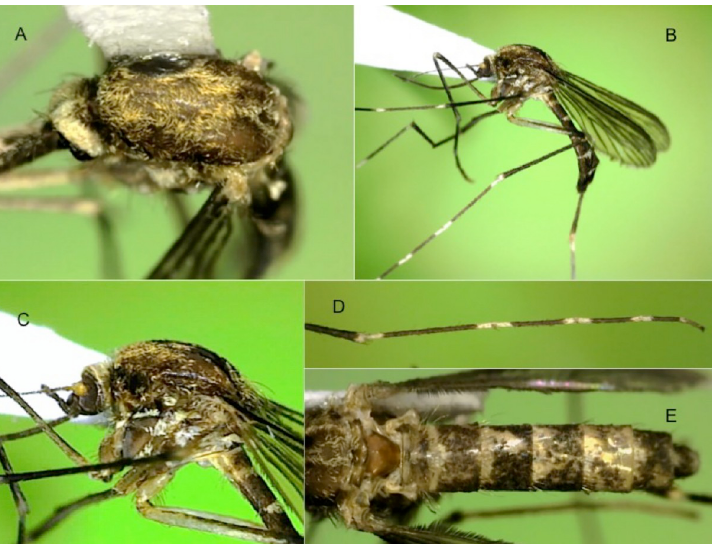
Fig 3. Adult female of Aedes ( Ochlerotatus ) amateuri . A: Dorsal view of the scutum. B: Laterial view of the body. C: Lateral view of thorax. D: Lateral view of foreleg. E: Dorsal view of abdomen. light brown scales on dorsolateral, lateral and ventral surfaces, the darkest scales usually dorso- lateral. Proboscis 1.1–1.2 length of forefemur, dark-scaled. Palpus about 0.2 length of probos- cis, with 3 obvious palpomeres, dark-scaled. Antenna subequal to proboscis in length; pedicel usually yellow, darker and with a few light or dark scales mesally; flagellomere 1 slightly swol- len, with white scales mesally. Thorax (Fig 3A): Acrostichal setae few, on anterior area of scu- tum; dorsocentral setae few, on anterior and posterior areas of scutum; prescutellar and supraalar setae numerous; humeral setae 2, 3. Scutellum with 10–12 setae on each lobe. Scutal scales narrow, curved, whitish, dingy white, or cream-colored on anteriorly, around prescutel- lar space and in antealar area, yellowish in diffuse narrow acrostichal and broader outer dorso- central lines, light brown to light reddish brown in diffuse inner dorsocentral line, and dark reddish brown laterally from anterior promontory to above wing base. Scutellum with numer- ous narrow curved cream-colored scales, those on lateral lobe sometimes yellowish to brown. Paratergite without scales (Fig 3B). Antepronotum with setae and brown and/or cream-col- ored narrow curved scales. Postpronotum with vertical row of setae posteriorly, narrow curved mostly brown scales dorsally, and broad flat white scales posterioventrally. Pleura with light- colored setae on postspiracular area, prealar knob, proepisternum, upper and posterior meso- katepisternum and upper mesepimeron; with broad flat mostly appressed white scales on post- spiracular and subspiracular areas, the latter patch with dorsal extension to postpronotum, lower proepisternum, proepisternum, in patch on prealar knob below setae, in upper patch on mesokatepisternum that does not reach anterodorsal corner of sclerite, in lower patch along posterior margin of mesokatepisternum, and in large, somewhat divided patch on upper 0.67 of mesepimeron (Fig 3C). Wing : Completely dark-scaled. Halter : Light-scaled. Legs (Fig 3D): All coxae with broad flat white scales on anterior surface, forecoxa usually with additional dark scales. All femora with white-scaled knee spot also involving base of tibia; fore- and midfemora predominantly dark-scaled, white scales on posterior and ventral surfaces; hindfemur mostly white-scaled with dorsal dark-scaled line beginning near base and broadening distally to become an apical dark-scaled band. Tibiae each with narrow incomplete apical white band. Fore- and midtarsus with white scales in complete narrow band at base of tarsomere 1, in